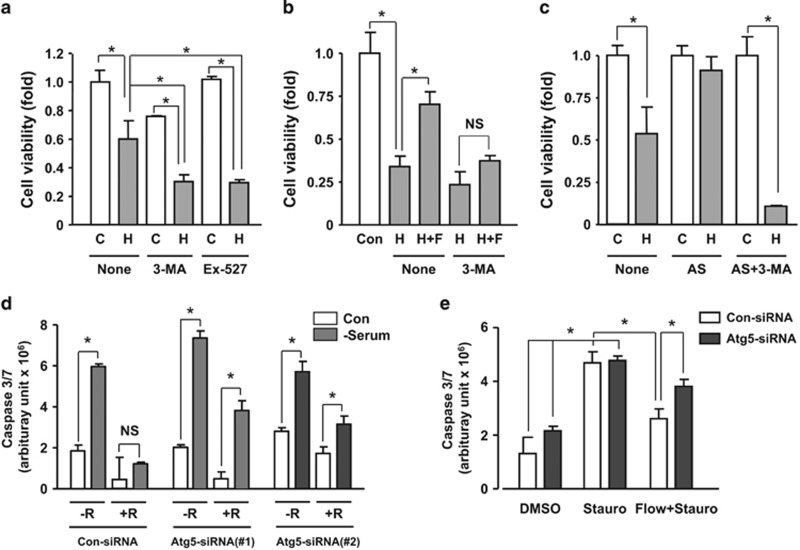
Autophagic response had cytoprotective actions in endothelial cells. (a) Flow-adapted cells were pretreated with the autophagy inhibitor 3-MA (10 μM) or the Sirt1 inhibitor EX-527, and acutely challenged with a high concentration (600 μM) of H2O2 for 2 h. (b) Effects of laminar flow adaptation on H2O2-induced cell death in the absence and presence of 3-MA. (c) Effects of autophagy induction by amino-acid starvation (by incubating cells in Hank's balanced salt solution for 4 h) in static cells on H2O2-induced cell death. (d) Effects of Atg5 gene silencing with different siRNA sequences on the cytoprotective effects of resveratrol (10 μM) assessed by serum deprivation-induced cell apoptosis. (e) Effects of Atg5 gene silencing on the cytoprotective effects of laminar flow assessed by staurosporine (100 nM)-induced cell apoptosis. Data are mean±S.E.M. *P<0.05, one-way analysis of variance, n=4–5. H, H2O2; F, flow; AS, amino-acid starvation; R, resveratrol; Stauro, staurosporine; C, control; NS, no significance